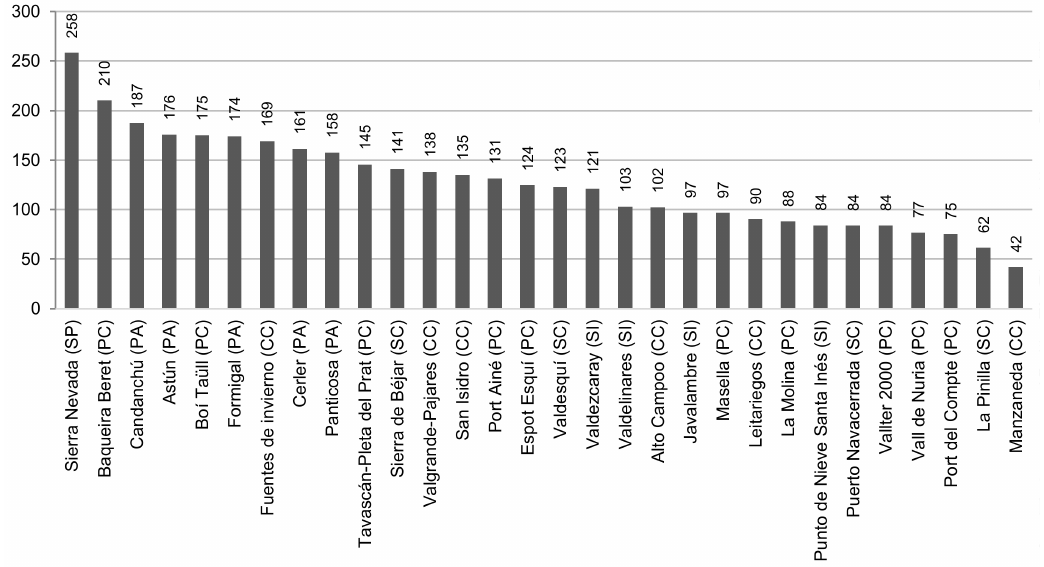
Figure 4. Mean values of the maximum snow depth, winter seasons 2009/2010 to 2014/2015 (cm). Source: Information provided by Infonieve.es in June 2015. Abbreviations stand for: CP (Catalan Pyrenees); AP (Aragonese Pyrenees); CM (Cantabrian Mountains); IS (Iberian System); CS (Central System); and PS (Penibaetic System). Note: Information for the resort of Lunada not